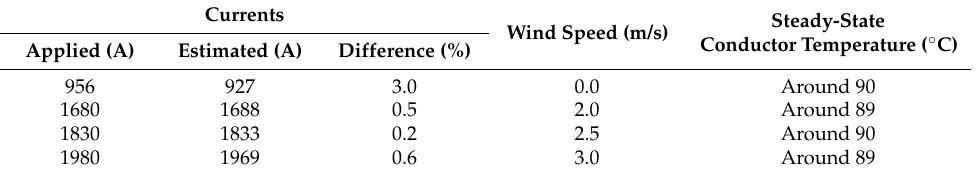
Table 6. Results of steady-state temperature with different currents and wind